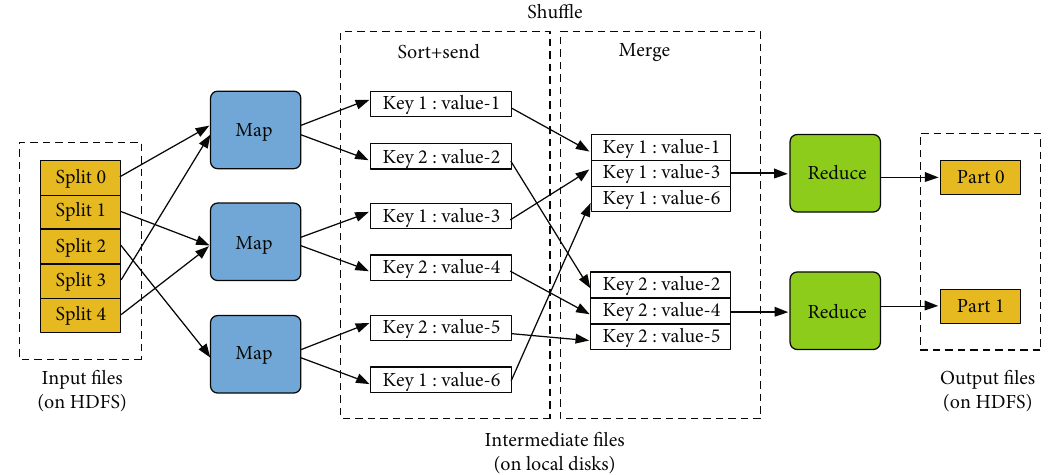
Figure 2: MapReduce inputs and outputs.